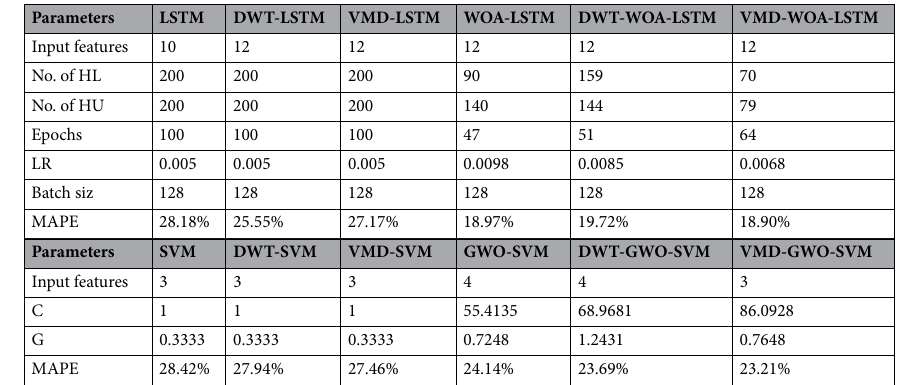
Table 3. The experiment parameters of the proposed